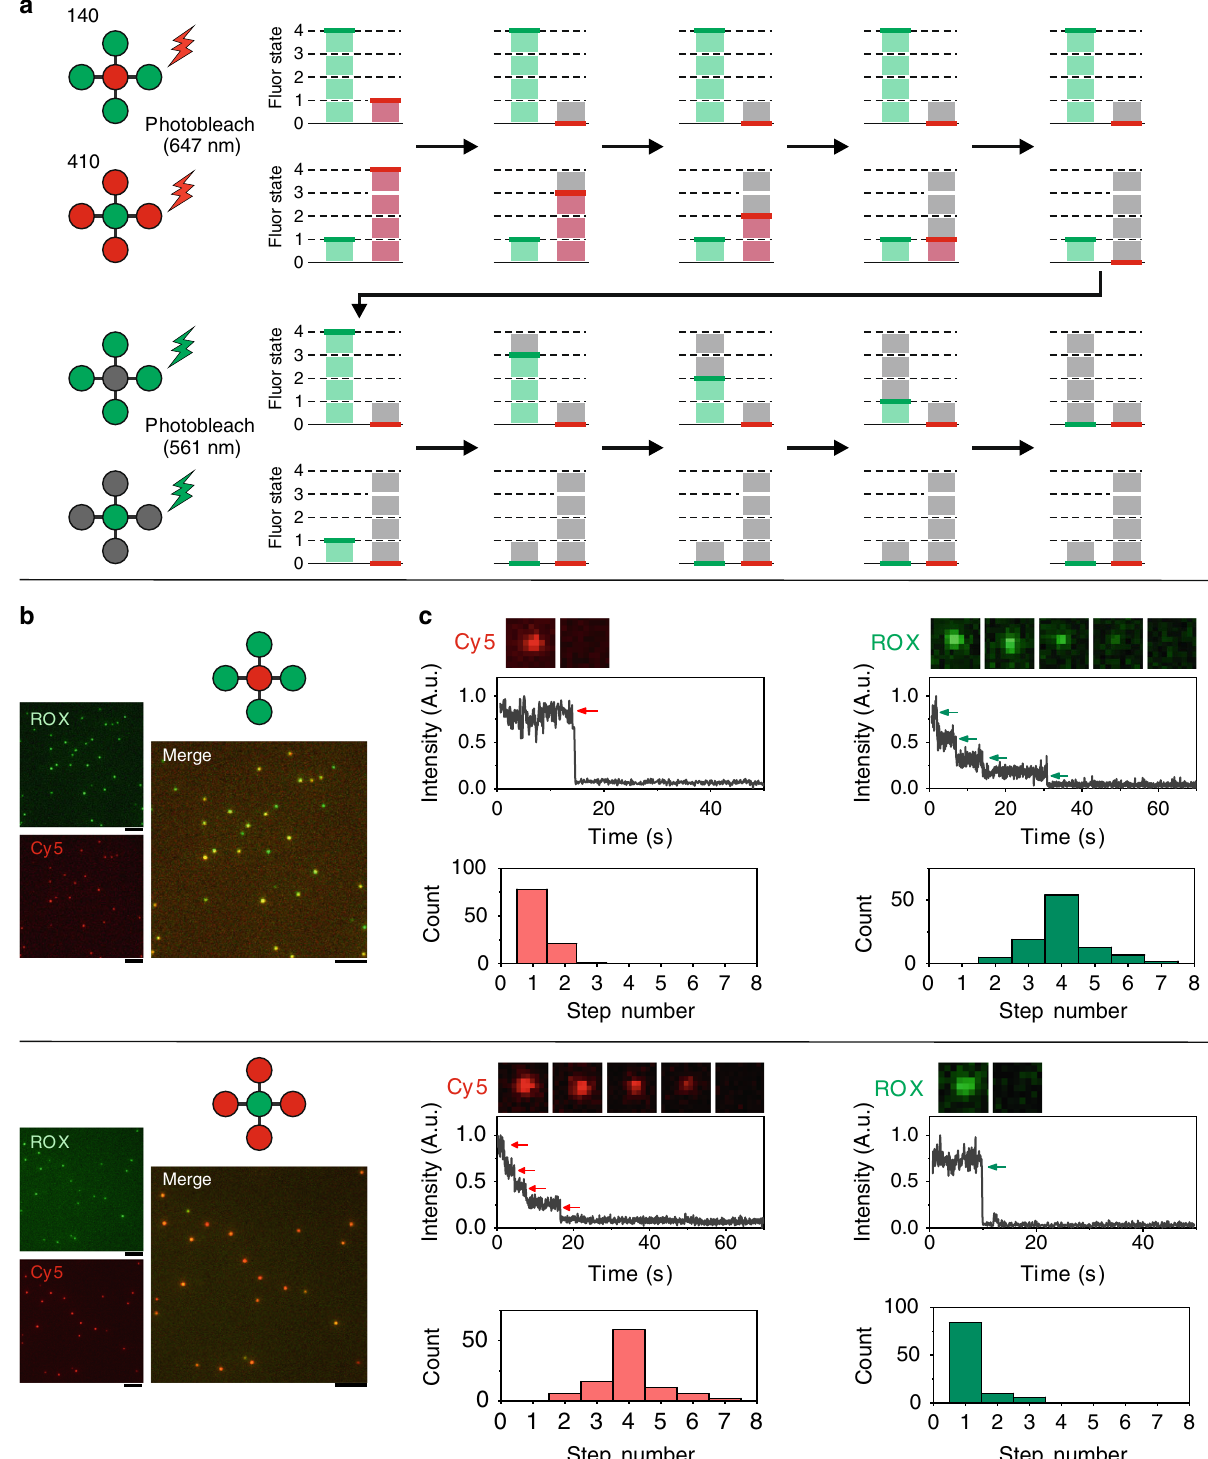
Fig. 4 Decoding FDF barcodes via quantised photobleaching. a Schematic illustration of the quantised photobleaching of different FDF barcodes (ID: 140 and 410). b Fluorescent microscopic images of the FDF barcodes. Scale bar, 5 µ m. c Single-molecule fl uorescence quenching snapshots, kinetics of the FDF barcodes, and distributions of quenching step counts ( N = 100 for each ROX numbers. These results con fi rmed that the quantised FDF estimated that over 80% barcodes can be correctly decoded barcodes can be decoded at the single-molecule level via (Supplementary Fig. 16), and the decoding errors might be photobleaching and single-particle fl uorescence tracking.